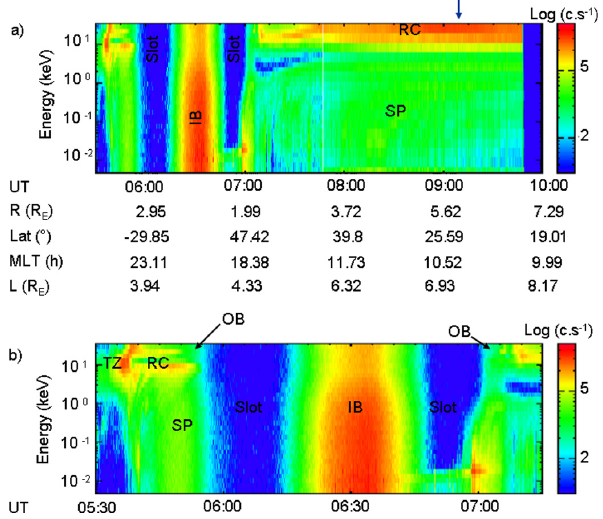
Fig. 5. Data from the CIS/HIA instrument on board C1 for the 15 May 2009 perigee pass as energy-time spectrograms, in ion counts (corrected for the detection efficiency) per second. (a) dur- ing the whole time interval under study, (b) during the perigee pass. In each plot, TZ: transition zone, RC: ring current, SP: sub-keV population, IB and OB: inner and outer radiation